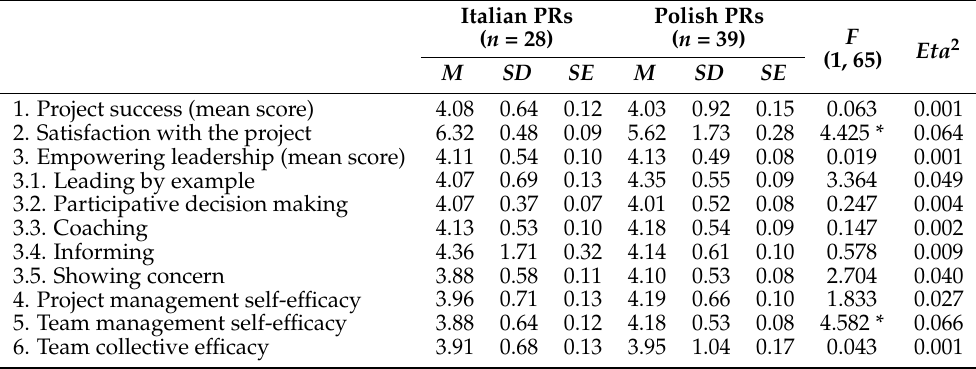
Table 2. Descriptive statistics for measured variables in Italian and Polish samples.